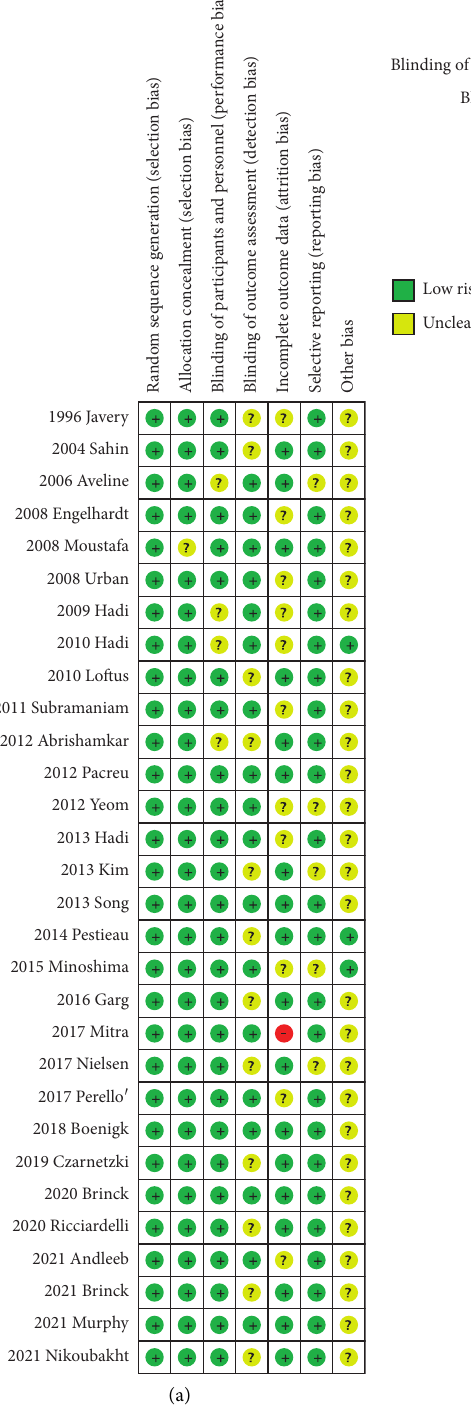
(WMD, − 6.72; 95% CI − 12.02 to − 1.43, P < 0 . 001, GRA-